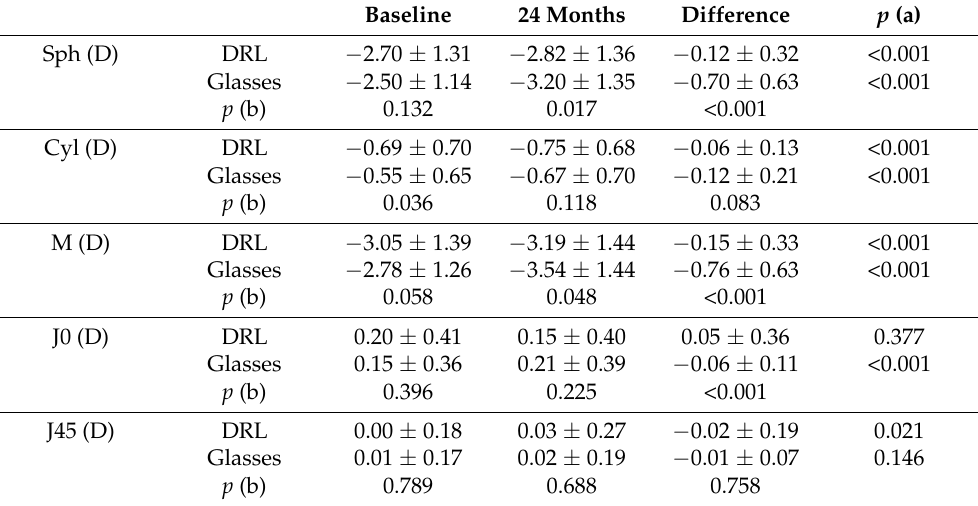
Table 4. Data from the longitudinal study at 24 months of treatment in the comparison between DRL and glasses ( n =